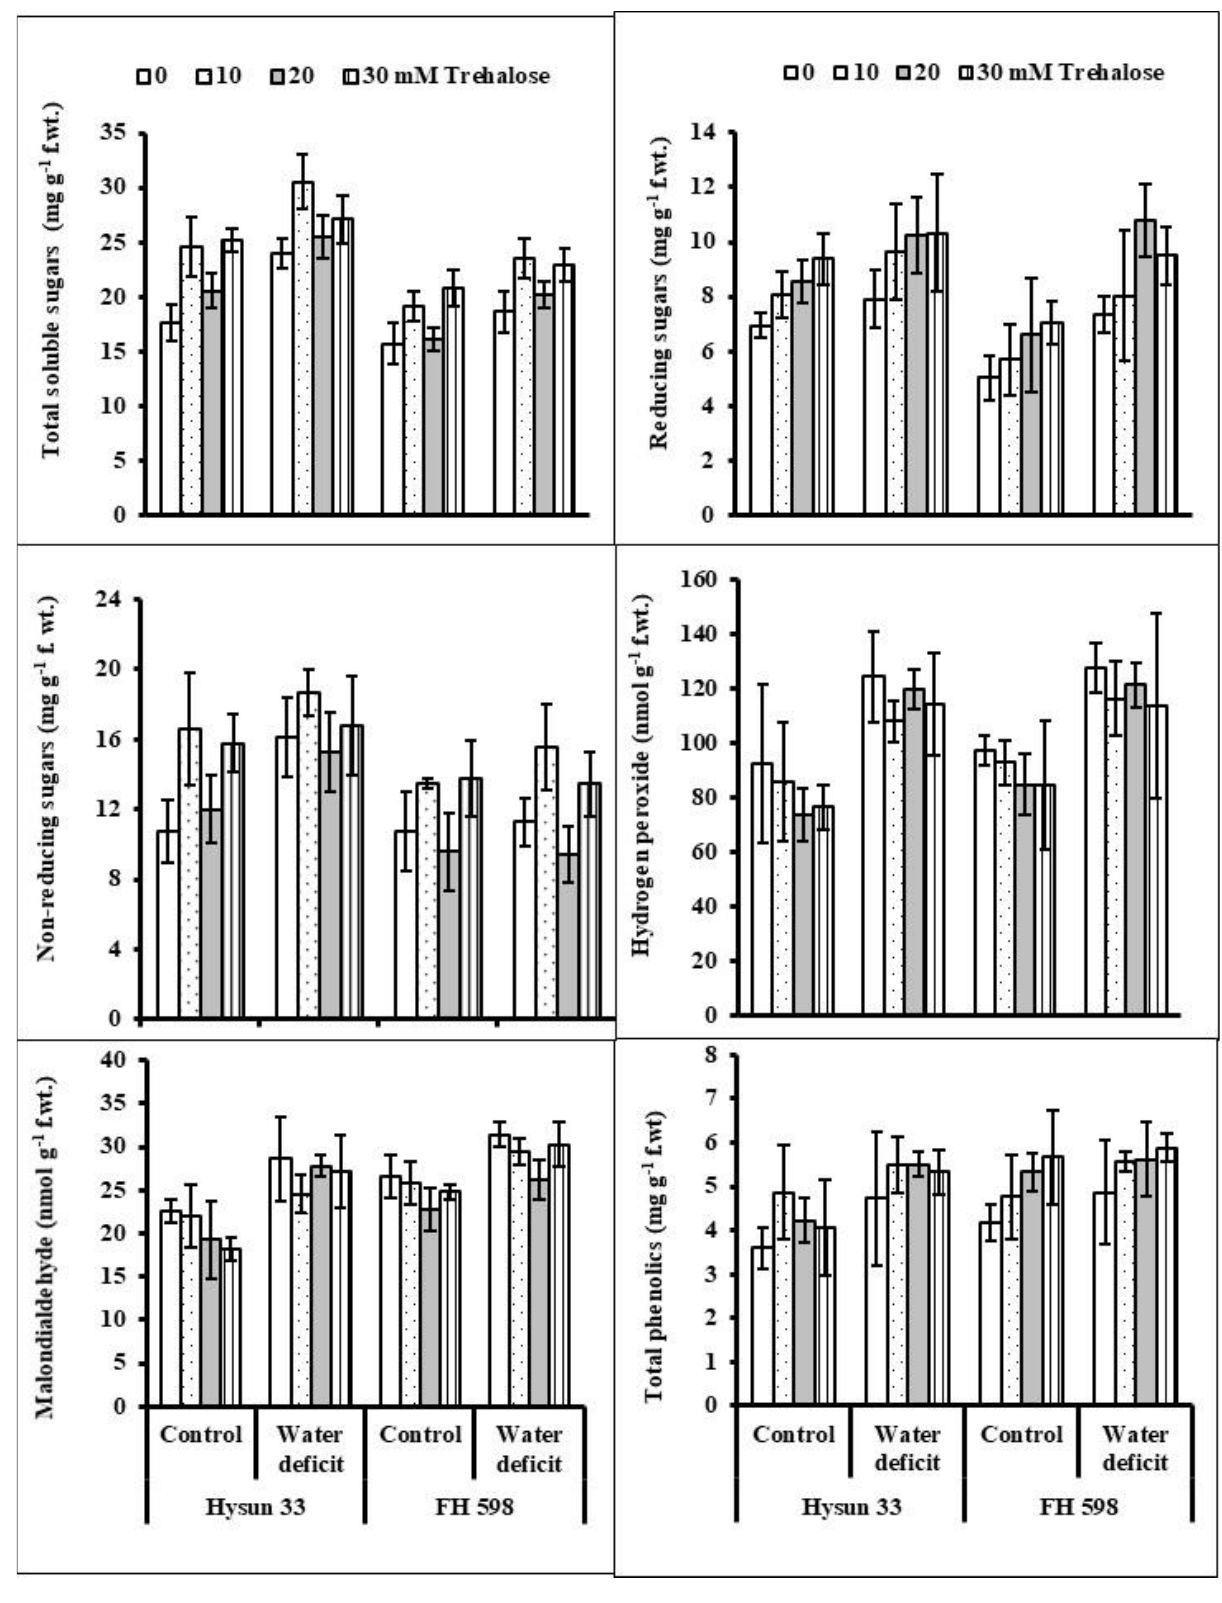
Figure 2. Total soluble sugars, reducing sugars, non-reducing sugars, hydrogen peroxide, malondialdehyde, and total phenolic content of two drought-stressed and non-stressed cultivars of sunflower ( Helianthus annuus L.) plants subjected to varying levels of foliar-applied trehalose (mean ± S.E.).